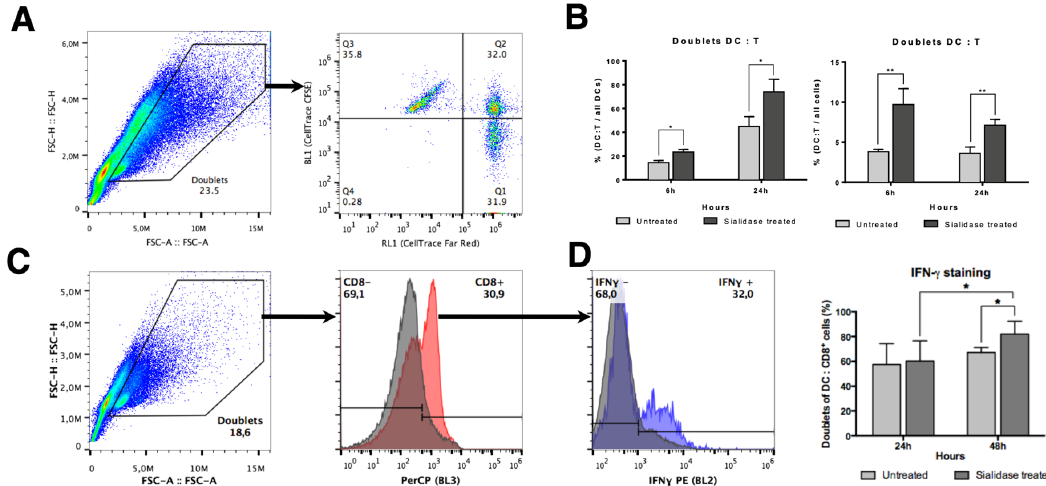
Figure 6. Co-cultures of DCs (untreated or sialidase treated) with autologous CD8 + T cells. ( A ) Gating strategy used to identify DC:T cell interactions. Co-cultures of FarRed ® -labeled DCs with CFSE-labeled autologous CD8 + T cells were analyzed by flow cytometry. Single cells were excluded and doublet identification was considered when the two fluorescences co-localize. ( B ) Percentage of DC:T cell doublets in relation to all DCs.. The number of doublet DC:T cell and of the number of total DCs (as evaluated by staining with FarRed fluorescence) was quantified by flow cytometry at 6 h and 24 h of co-culture. The graph represents the percentage of DC:T cell doublets in relation to the total number of DCs (N = 6). ( C ) Percentage of DC:T cell doublets in relation to all cells.. The number of doublet DC:T cell and of the number of total events was quantified by flow cytometry at 6 h and 24 h of co-culture. The graph represents the percentage of DC:T cell doublets in relation to the total number of cells (doublet and non-doublet) (N = 6). ( D ) Intracellular IFN- γ production was evaluated at 24 h and 48 h of co-culture. The left panel shows the gating strategy, which considers doublet populations of DC:T cells stained with the anti-human CD8 (HIT8a) antibody and with anti-IFN- γ (B27). The right panel shows a graph representing the percentage of CD8 + cells that express IFN- γ in relation to the total number of DC:T cells interacting (N = 5). Values presented as mean ± SEM. Statistically significant di ff erences are indicated by asterisks (* p ≤ 0.05, ** p ≤